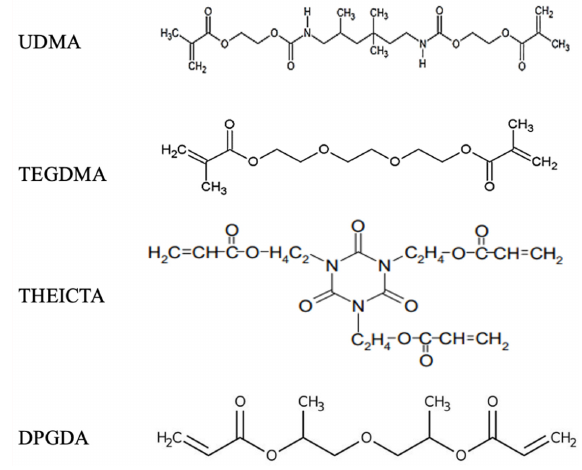
Figure 1. The chemical structures of the diluent and structural monomers. Table 2. The compositions of Mixtures A and B. Other Additives on Top of 100 wt.% Monomer Content in the Mixtures (Total of 100 wt.%) Monomer Mixture